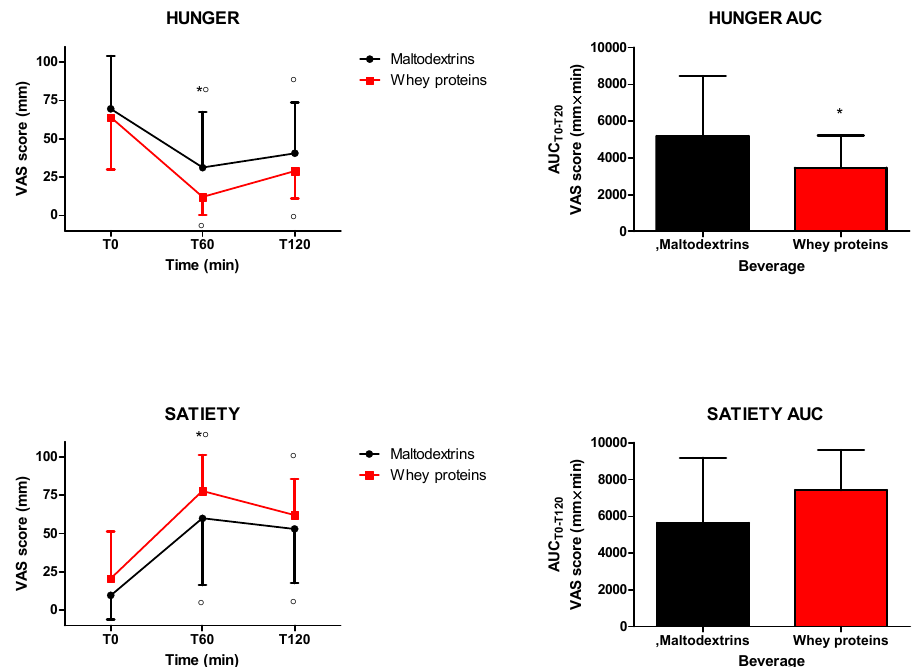
Figure 1. Changes of visual analogue scale (VAS) ratings of hunger (top panel) and satiety (bottom panel) in obese subjects after the intake of a drink (completely within 15 min starting at T0), containing whey proteins or maltodextrins. Values (curves on the left side and areas under the curve from T0 to T120 [AUC T0 − T120 ] on the right side) are expressed as mean ± SD. The number of subjects was 8. ○ p < 0.05 vs. the corresponding T0 value; * p < 0.05 vs. the corresponding value of the maltodextrins-treated group. One- or two-way ANOVA with repeated measures (with the single factor of group, or two factors of time and group and the interaction time × group, respectively), followed by the post hoc Tukey’s test, was used, when appropriate.